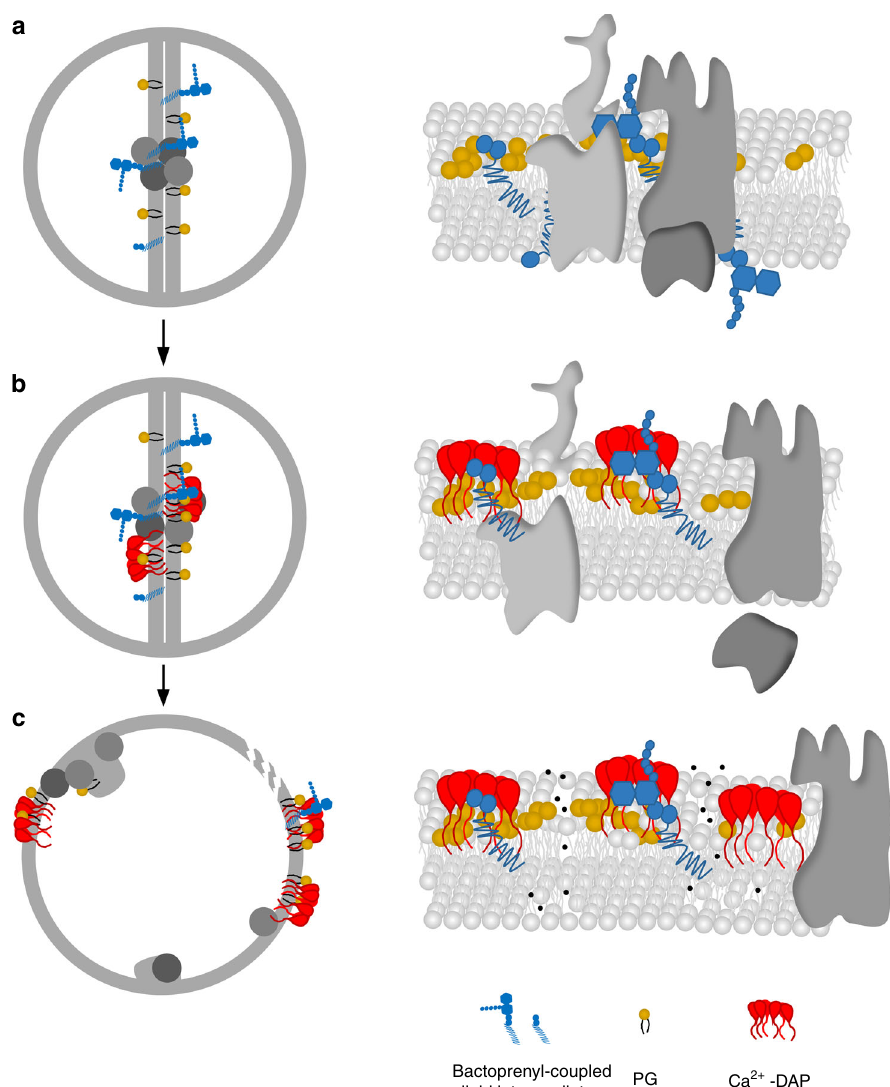
Fig. 6 Proposed model for the mechanism of action of DAP. a Orchestration of the cell wall biosynthesis machinery at the division septum of S. aureus in the absence of DAP. b Ca 2 + -DAP oligomerises and preferentially localises at the division septum enriched in anionic lipids, primarily PG, and C 55 P-coupled cell wall precursors. The formation of a tripartite complex of Ca 2 + -DAP with PG and bactoprenyl-coupled lipid intermediates blocks cell wall synthesis